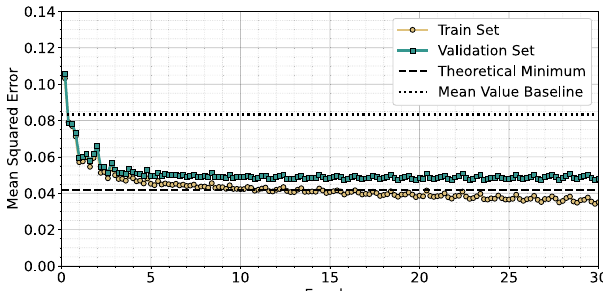
Fig. 6 Training logs for the feedforward network solving the inverse problem. The mean value baseline corresponds to Δ A and the theoretical minimum to Δ . Here, we used a network with two hidden layers, having 1024 and 512 neurons,